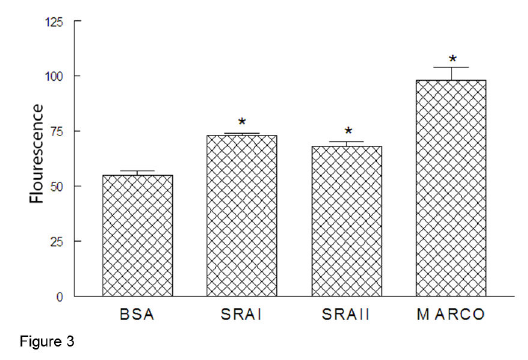
Figure 3. SP-A binds Scavenger Receptors. FITC-labeled SP-A was incubated with immobilized bovine serum albumin (BSA) or purified SRA-I, SRA-II, or MARCO. SP-A was able to bind to all three scavenger receptors suggesting a means to enhance phagocytosis of flagellated bacteria; n=3, *p<0.05 when compared to BSA